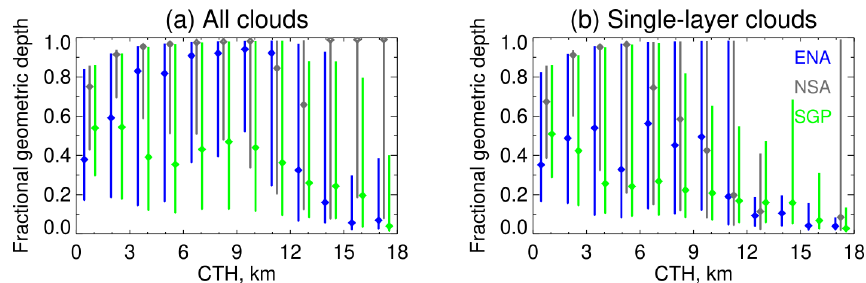
Figure 4. Median (points) and central 1 standard deviation (lines) of cloud FGD binned as a function of CTH for ARSCL data from three ARM sites. Panels show results for (a) all clouds and (b) single-layer clouds. Only bins with at least 1000 observations are populated. Colours indicate the ENA (blue), NSA (grey), and SGP (green) sites. The bin size is 1.5km; sites are slightly offset from bin centres for clarity.